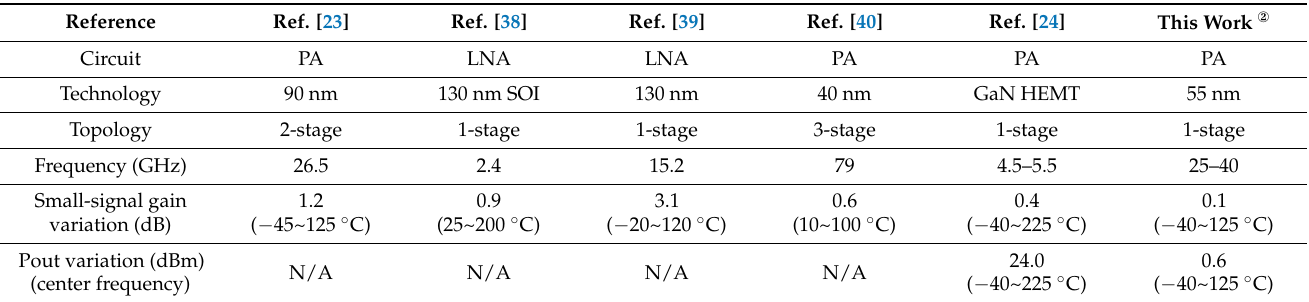
Table 1. Performance comparison with previous